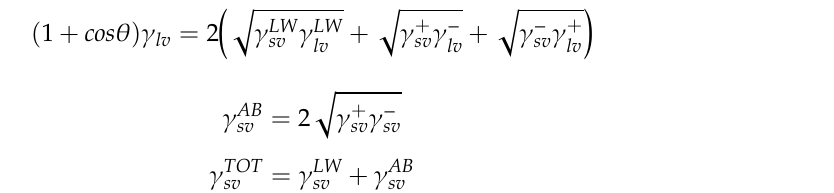
Table 2. Surface free energy parameters (mN / m) of the liquids used for contact angle measurements [87–91].